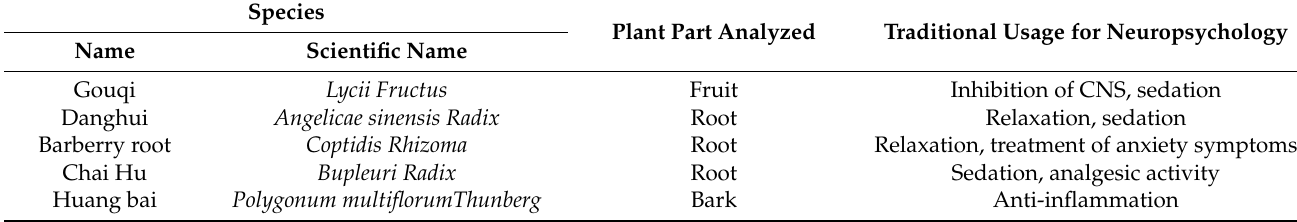
Table 3. Medicinal plant extracts screened for sedative–hypnotic activity.